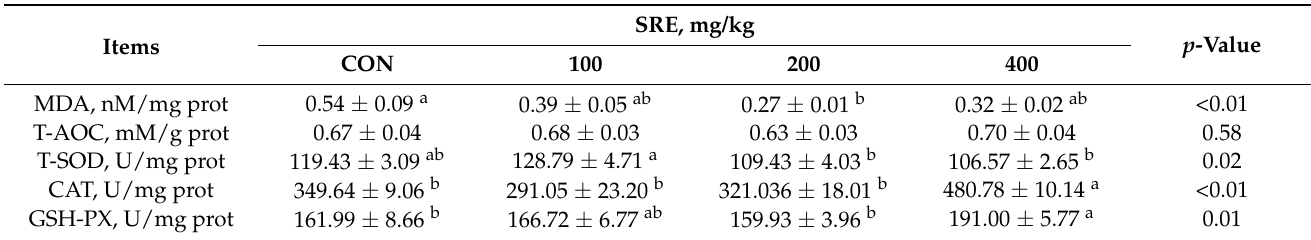
Table 5. Effects of supplementation with stevia residue extract in the diet on the liver antioxidant capacity of weaned piglets on day 42 of the trial (a) .